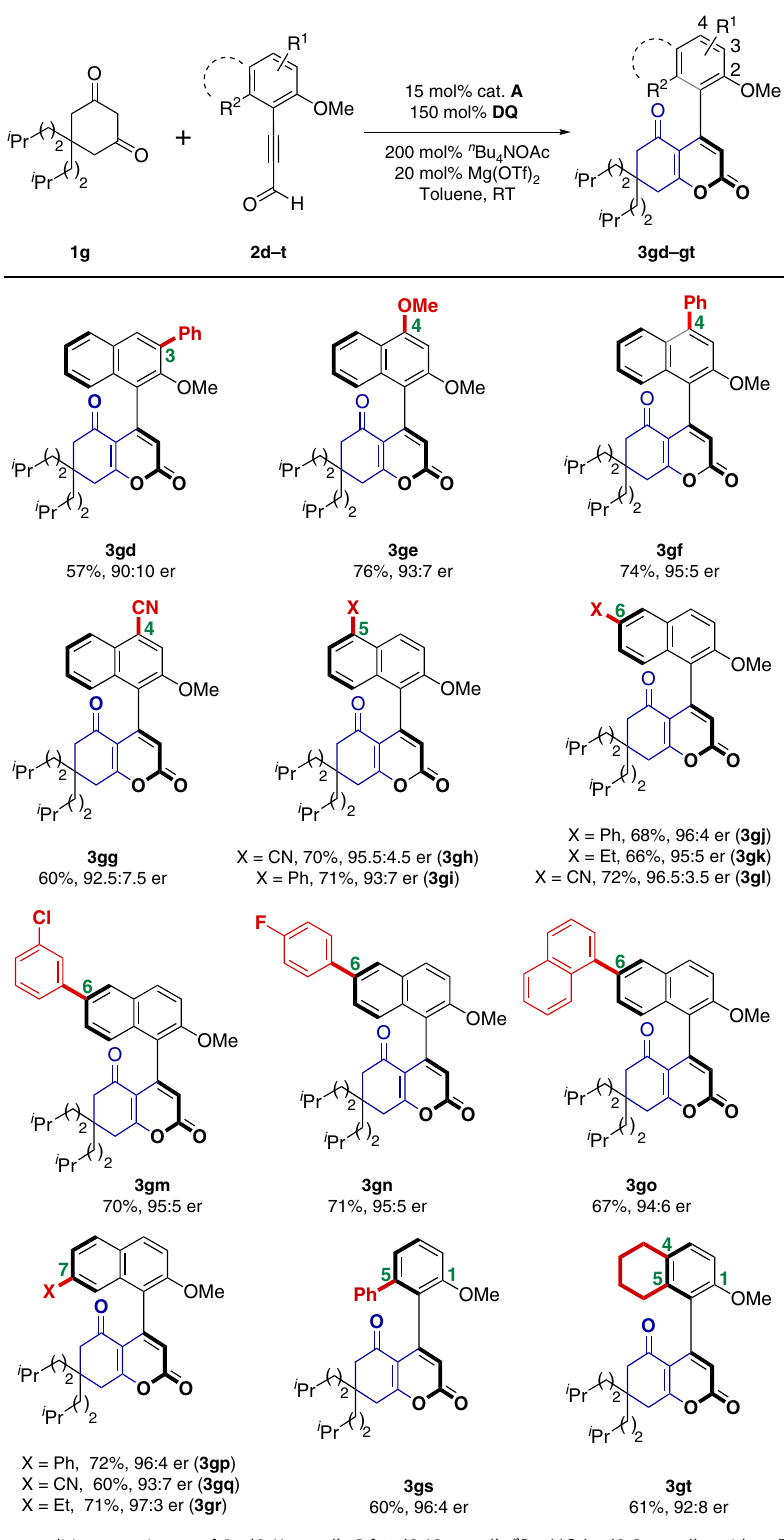
Fig. 4 Scope of ynals. Reaction conditions: a mixture of 1g (0.11 mmol), 2d − t (0.10mmol), n Bu 4 NOAc (0.2 mmol), oxidant E (0.15 mmol), Mg(OTf) 2 (20 mol%), and cat. A (15 mol%) in toluene (2.0 mL) was stirred at room temperature under N 2 for 24